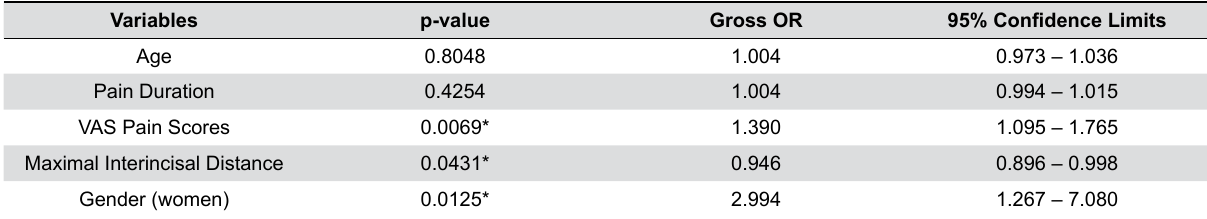
Table 2- Univariate analysis – Gross odd ratios